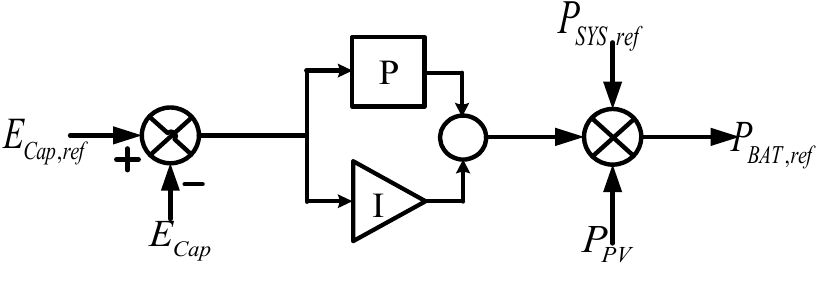
Figure 28. Control DC link voltage.